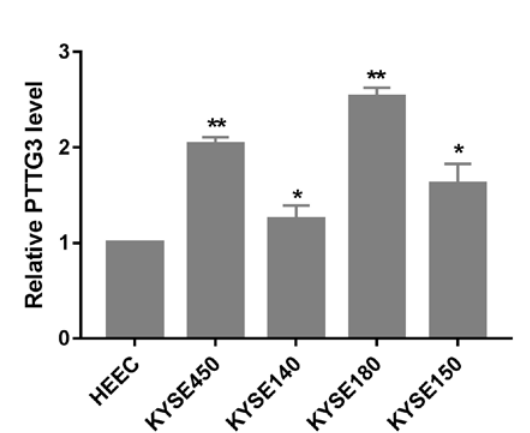
Figure 3: Baseline PTTG3P expression in ESCC cell lines and normal esophageal